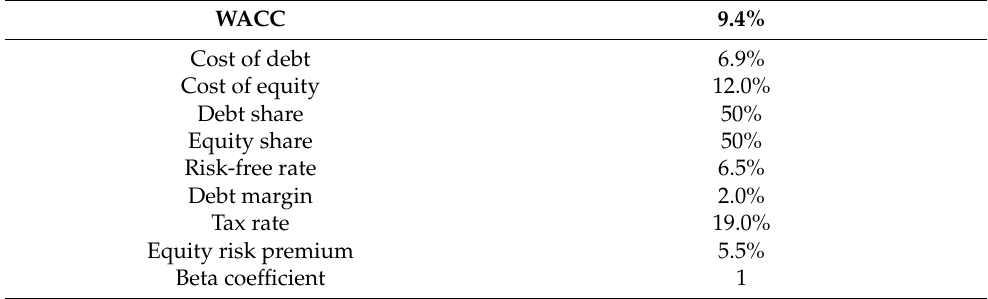
Table 1. WACC components (source: created by the authors in 2022).